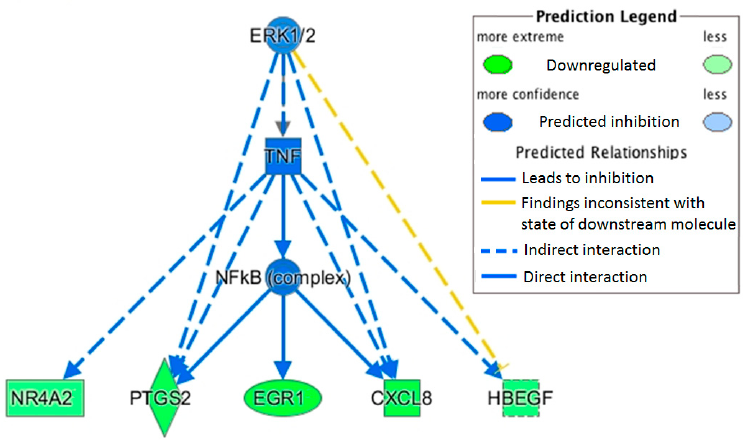
Figure 4. A schematic diagram of the extracellular signal–regulated kinase 1/2(ERK1/2) pathway.